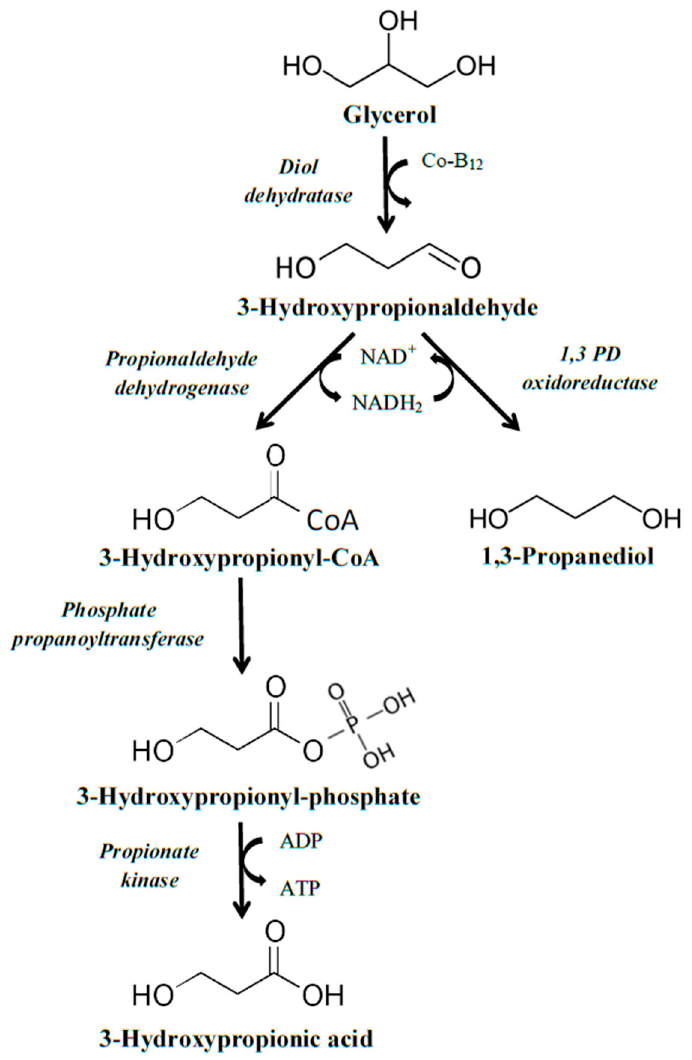
Figure 2. Conversion of glycerol to 3HP employing genes from the pdu operon.